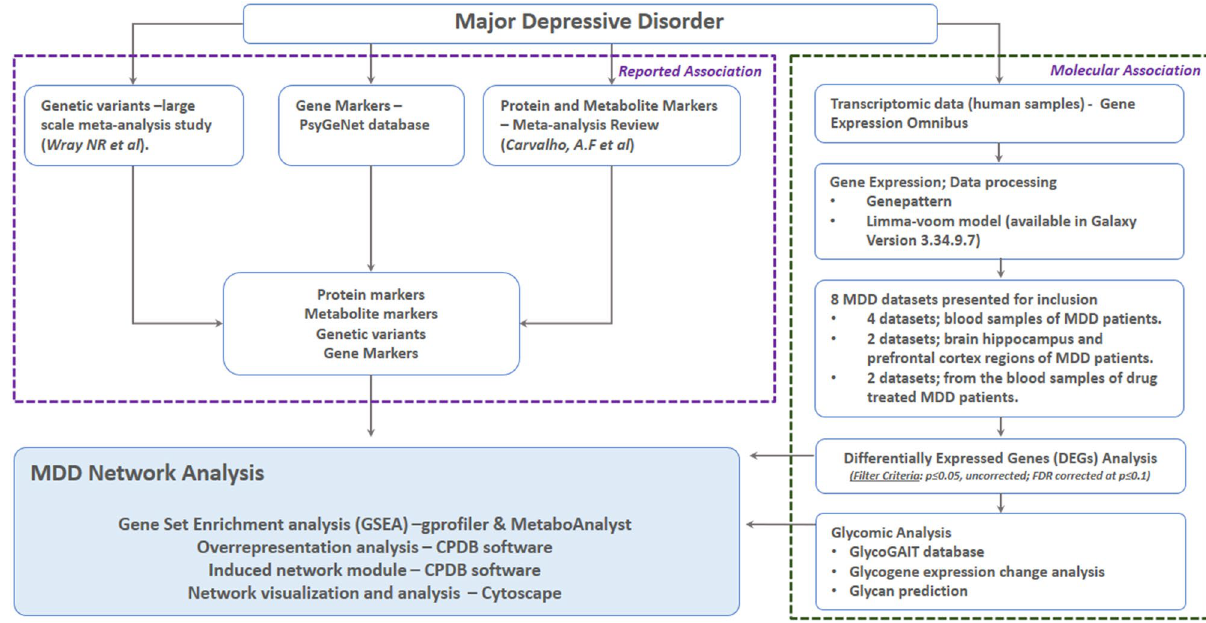
Figure 1. A flowchart depicting the sequential steps adopted in the current study for the integrative data analysis methodology. Various online software analysis tools as mentioned in the diagram were leveraged along with our proprietary GlycoGAIT database for detailed gene set enrichment analysis, complex protein–protein, gene regulatory and biochemical interaction pathway